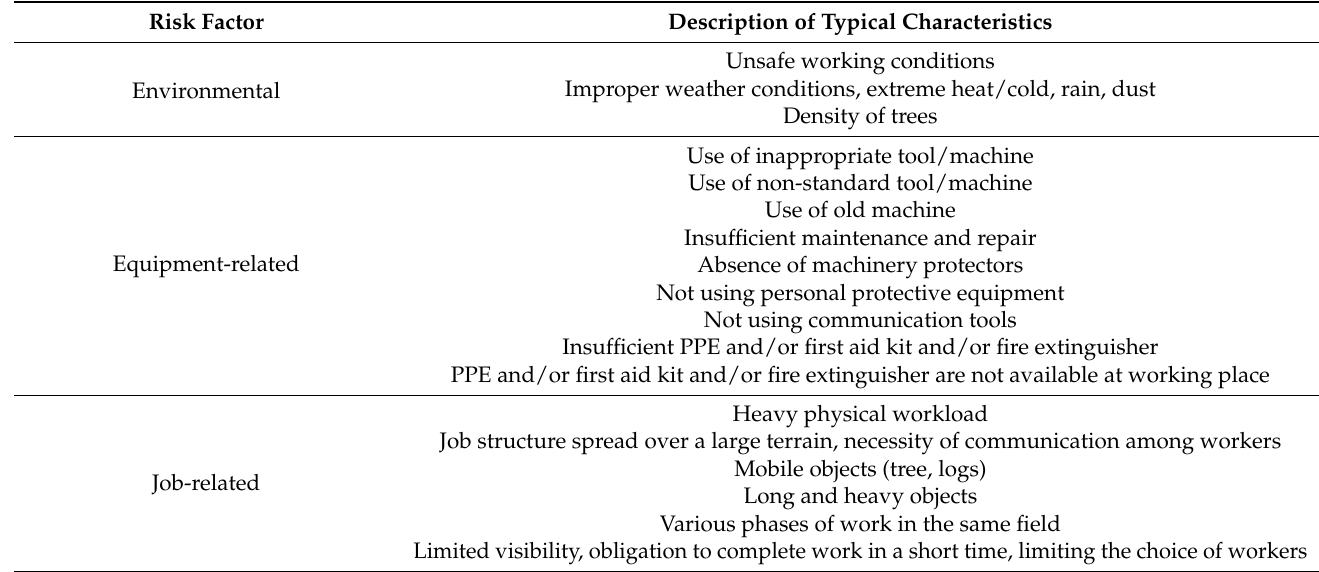
Table 1. Risk factor groups related to CAR of H&S issues issued in audit reports of FSC